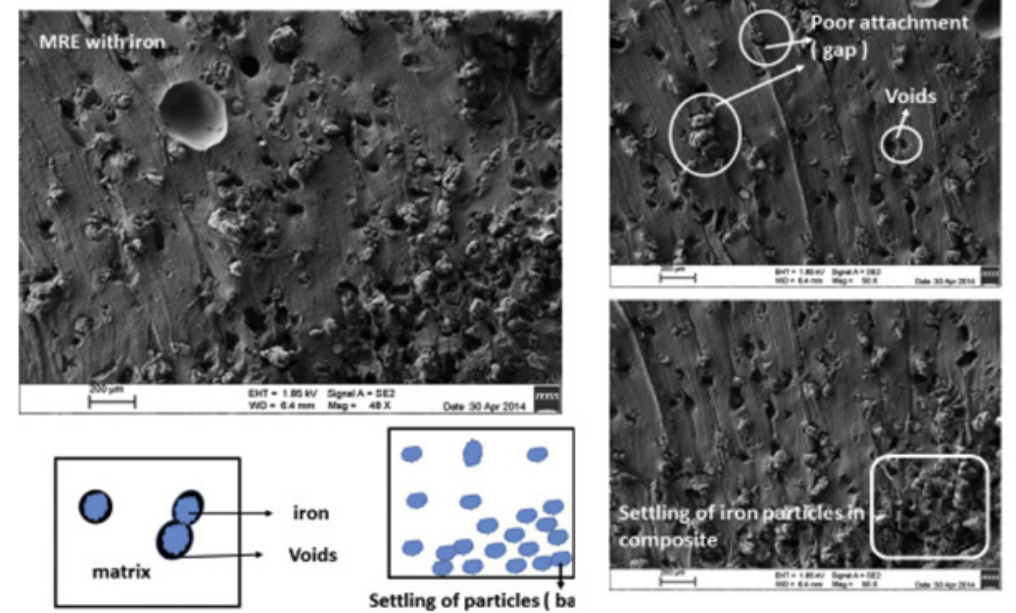
Figure 11. Anisotropic particle distribution within the matrix of the sample. The matrix shows the turbulence with voids. However, the particles show better attachment within the matrix.